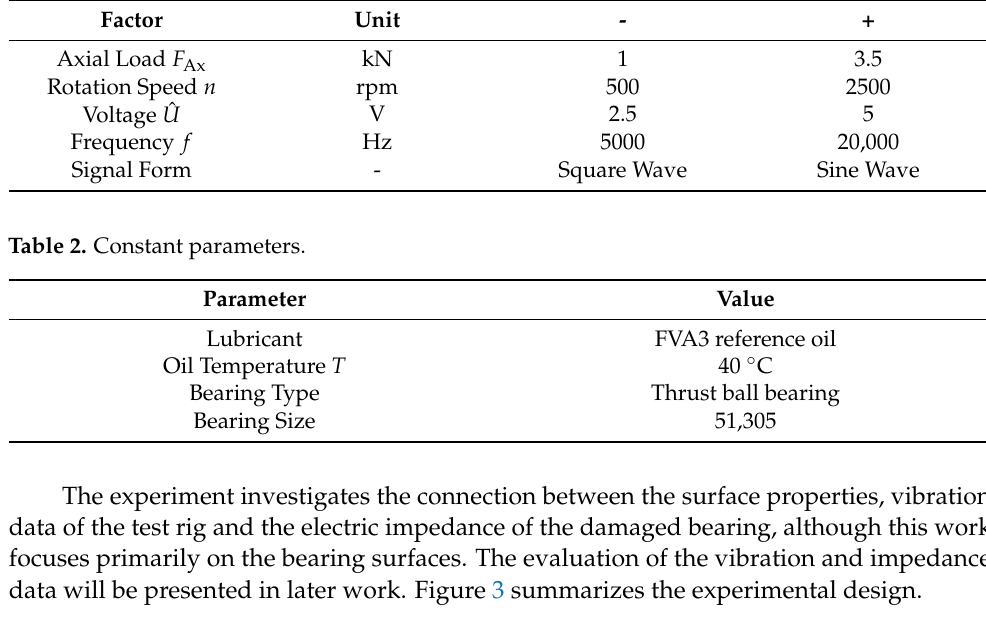
Figure 3. Design of the experiment.